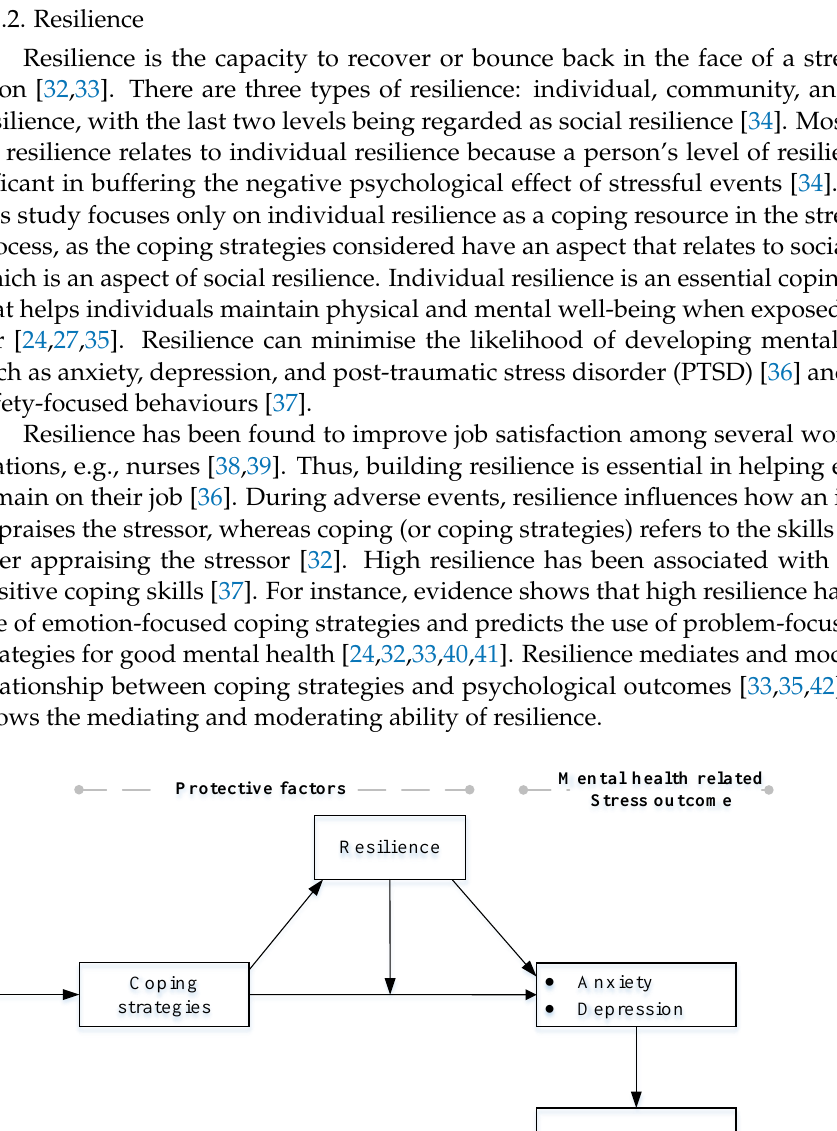
Coping strategies